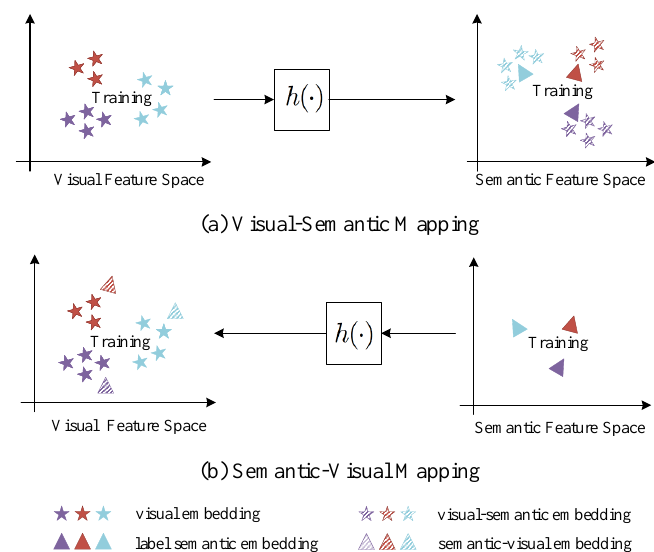
Figure 6. Illustration of phase B, feature mapping, including semantic-visual feature mapping and visual-semantic feature mapping. In this phase, a feature mapping model h ( · ) between two feature space is learned on the training